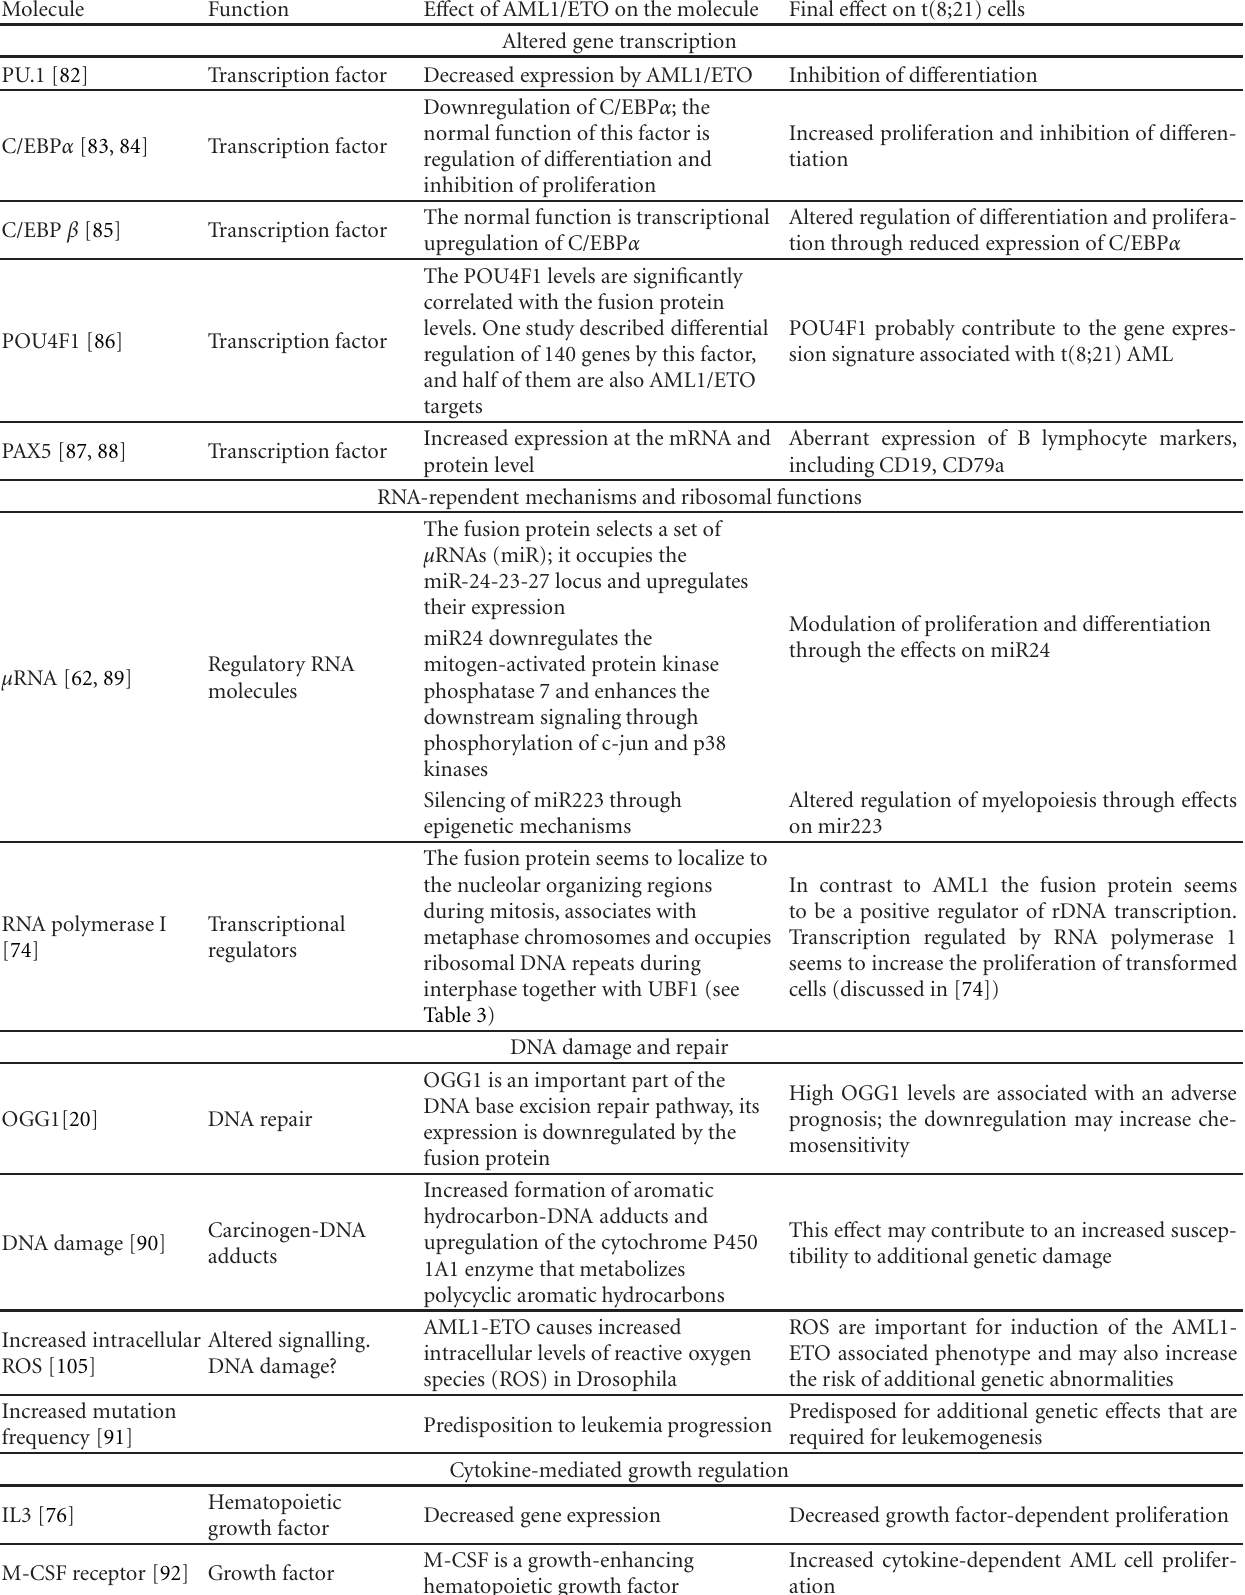
Table 4: Important molecular mechanisms involved in AML1/ETO-induced leukemic